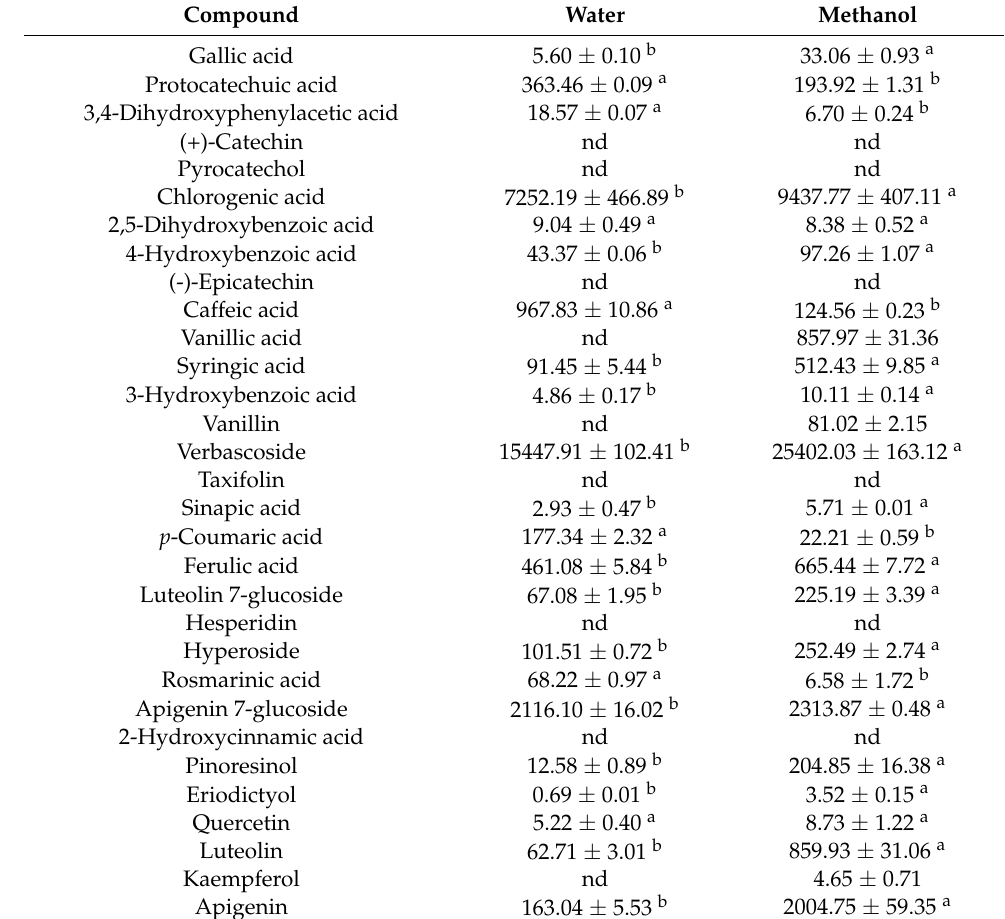
Table 1. Concentration ( µ g/g extract) of selected phytochemicals in S. cretica ssp. anatolica extracts x. .